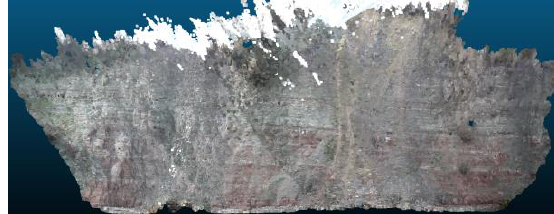
Figure 12. Control Points for Geolocating the Pole Survey